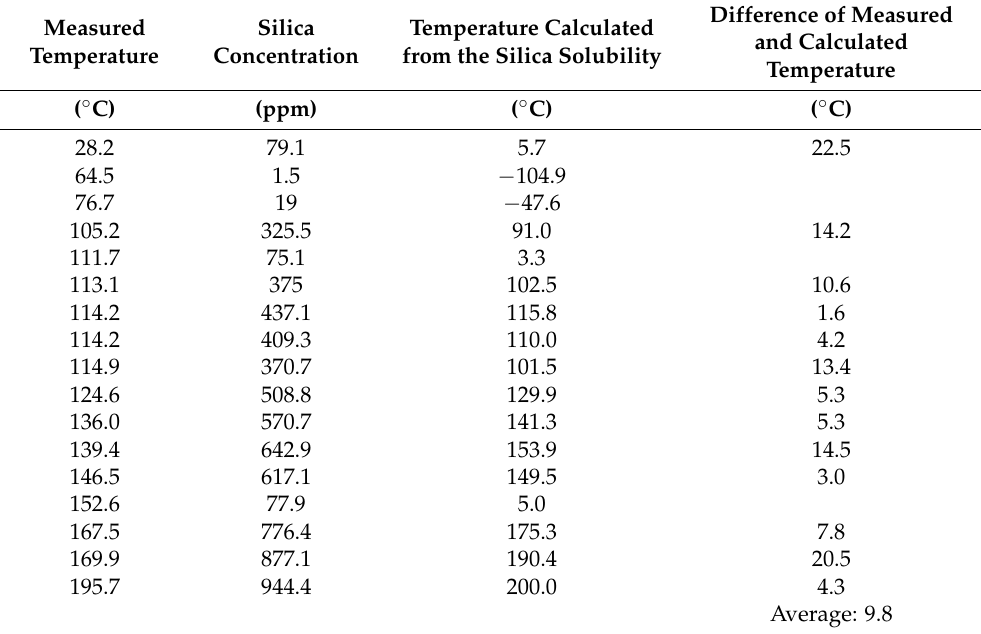
Figure 2. Dissolved silica concentrations of solution samples (black diamond) plotted as a function of temperature measured by a thermocouple in Cell 1 for temperature calibration with the amorphous silica (solid line) and quartz (dashed line) solubility curves reported in [17]. Amorphous silica and quartz solubility curves were originally described in [19–22]. Table 2. Difference between the measured temperature and temperature calculated from the silica solubility